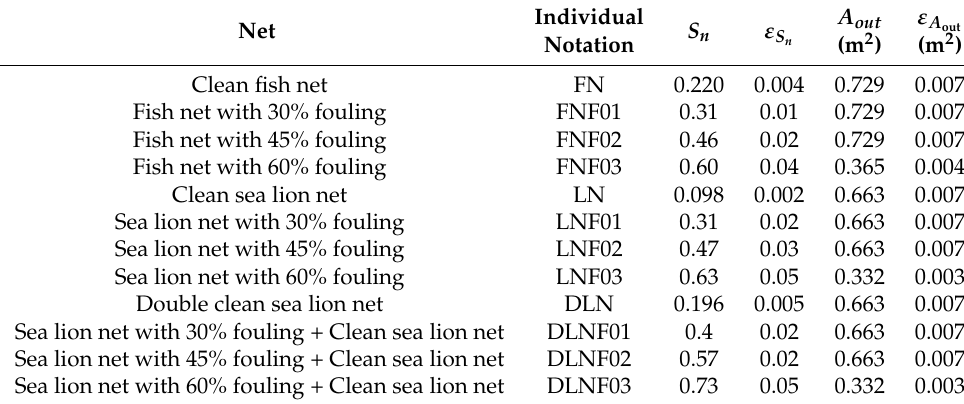
Table 1. Solidity index S n and characteristic area A out of tested nets. The values ε S errors in the variables S n and A out